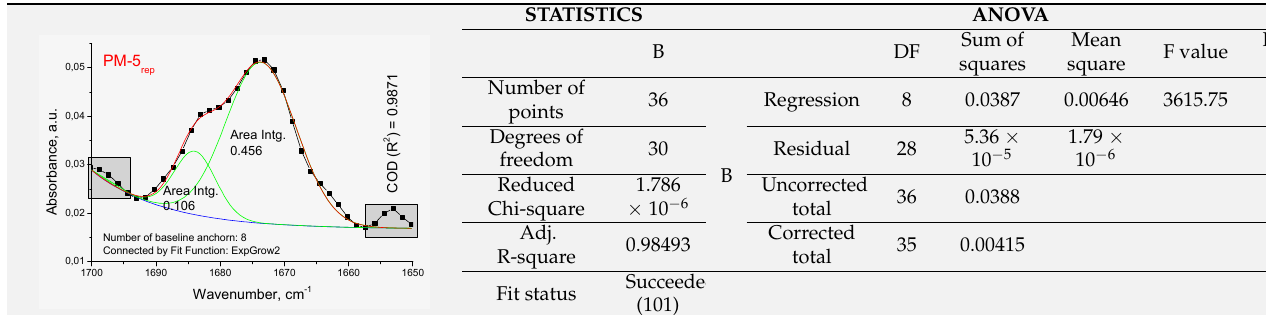
Table A6. Sample P-5 rep.